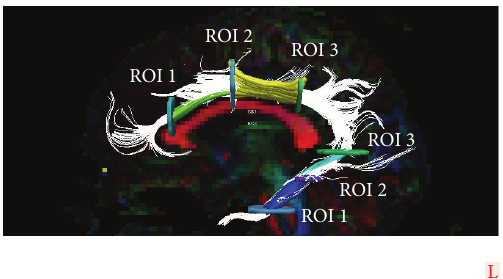
Figure 2: Example tract of cingulum with ROIs and tract segments. The cingulum and the parahippocampal part of the cingulum visualized as a 3D-tract with associated ROIs and tract segments overlaid on 2D FA-color map. Whole tract visualized in white. Cin- gulum: segment 1, green, and segment 2, yellow. Parahippocampal cingulum: segment 1, blue, and segment 2,